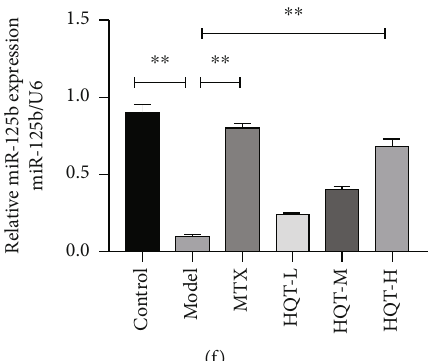
Figure 1: HQT attenuated RA in fl ammation by modulating miR-125b. Mice were divided into six groups: control group (saline), model group (CIA induction), MTX group (MTX, 1 mg · kg − 1 ), HQT-L (CIA mice that received low dose HQT of 9.4g/kg, low dose), HQT-M (CIA mice that received medium dose HQT of 18.8 g/kg, medium dose), and HQT-H (CIA mice that received high dose HQT of 37.6g/ kg, high dose). (a) Schematic diagram of the study. (b) Representative pictures of the mouse hind paw on day 30. (c) Joint swelling was assessed by measuring the ankle joint diameter with a pocket thickness gauge ( n = 8 ). (d) Change of ankle swelling was analyzed. (e) The cytokine protein levels including TNF- α , IL-1 β , and IL-6 in the serum of mice from di ff erent groups were measured by using an ELISA assay ( n = 8 ). (f) The mRNA expression of miR-125b in the serum of mice from di ff erent groups was evaluated by qRT-PCR ( n = 8 ). ∗ p < 0 : 05 , ∗∗ p < 0 : 01 , and ∗∗∗ p < 0 : 001